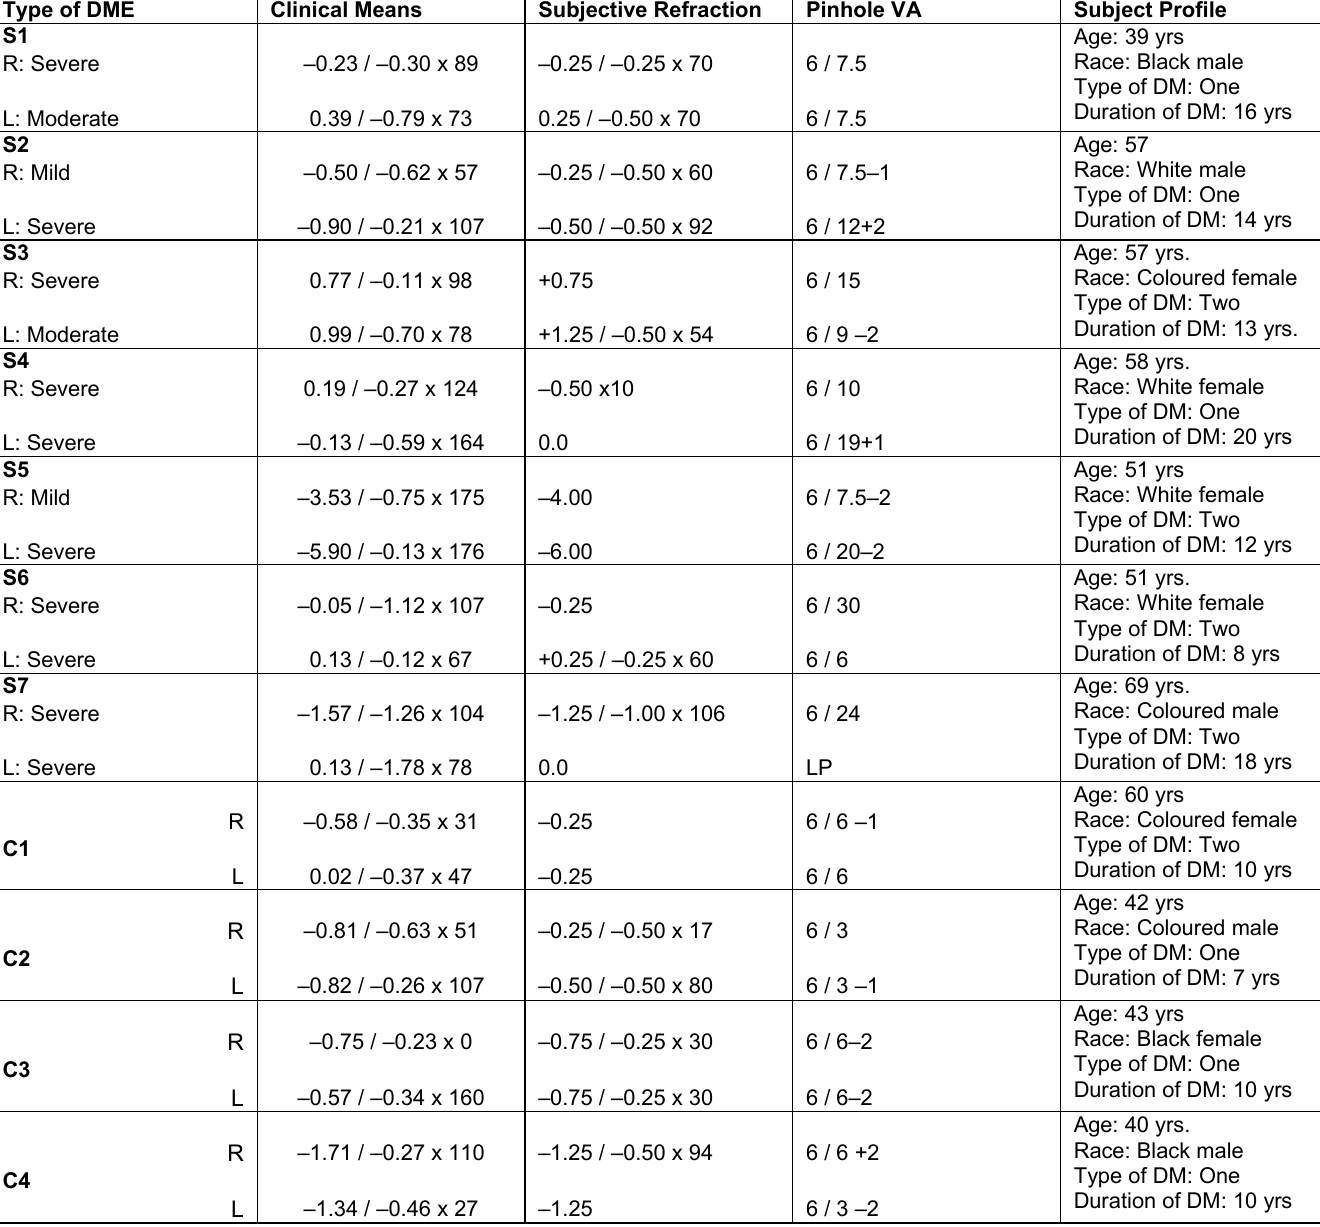
Table 1 .Clinical means, subjective refraction, acuities and profiles of subjects with DME (represented by S), and control subjects (represented by C). LP denotes light perception. Diagnosis of the severity of DME that was made on each eye by the ophthalmologists are indicated next to each